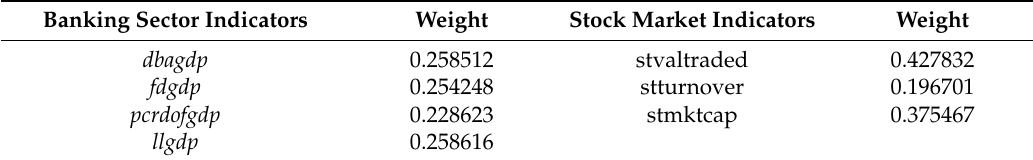
Table 3. Weights obtained from